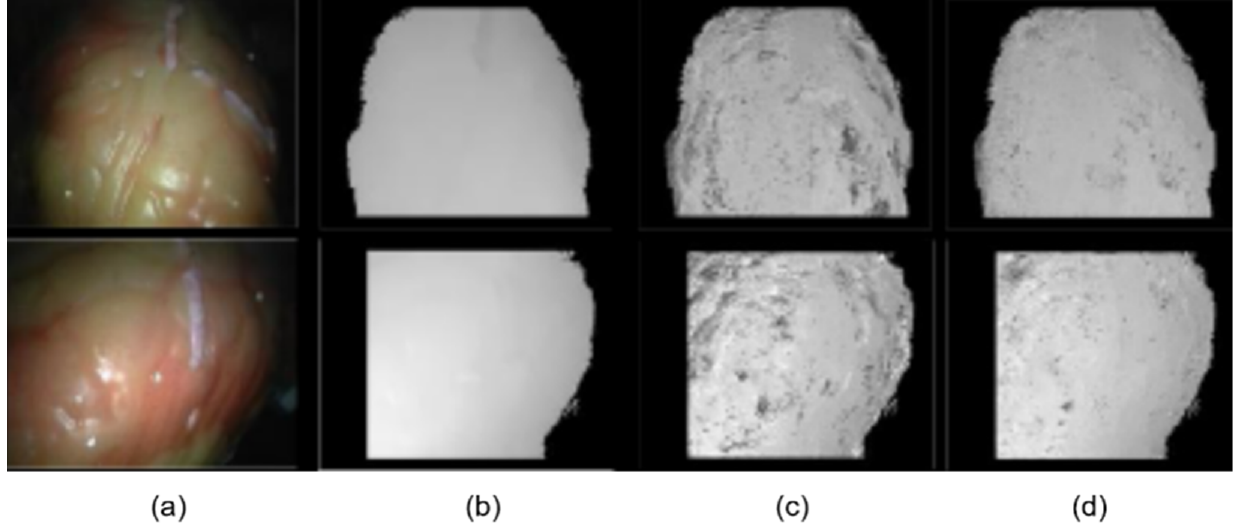
Figure 2. The corresponding matching results of the census before and after improvement. ( a ) Left image of heart model; ( b ) standard parallax map; ( c ) traditional ( d ) improved census corresponding parallax map.